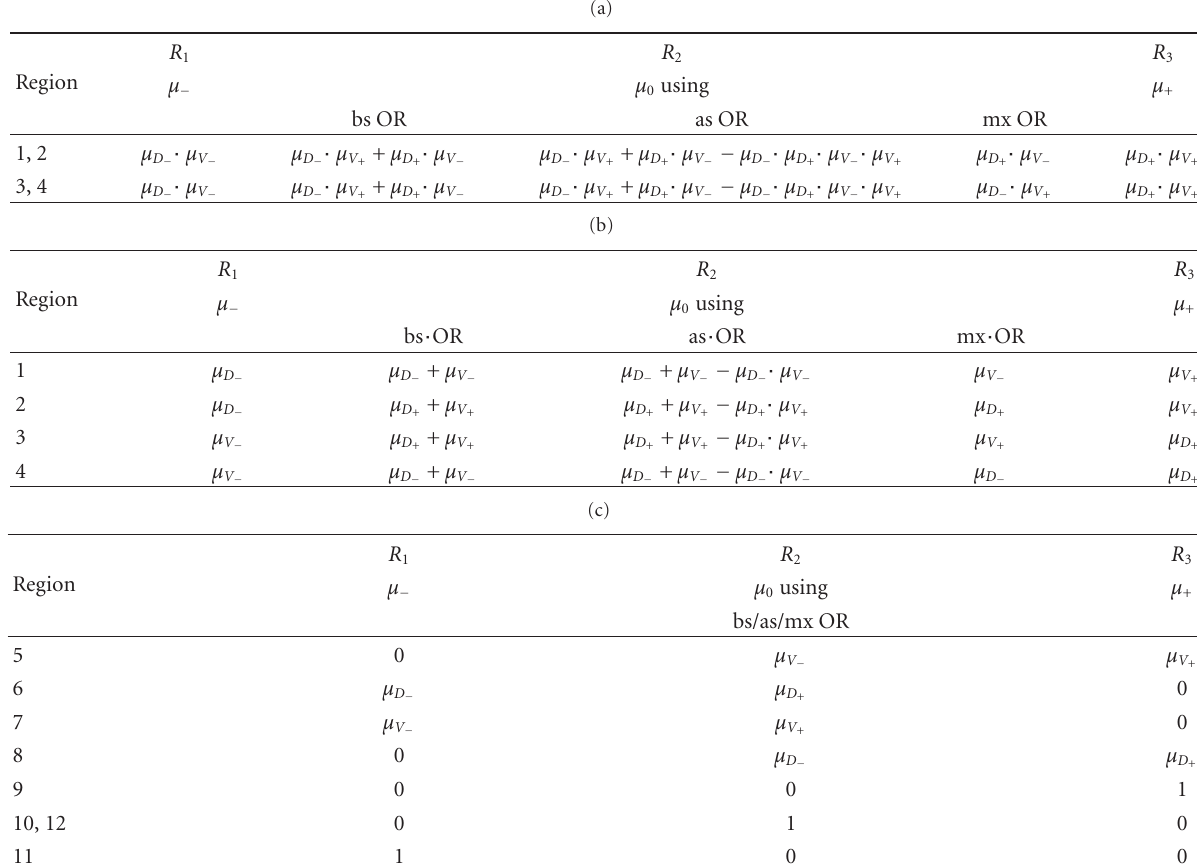
Table 1: (a) Outcomes of antecedent part of control rules: using ap AND. (b) Outcomes of antecedent part of control rules: using mn AND. (c) Outcomes of antecedent part of control rules: using ap/mn AND.